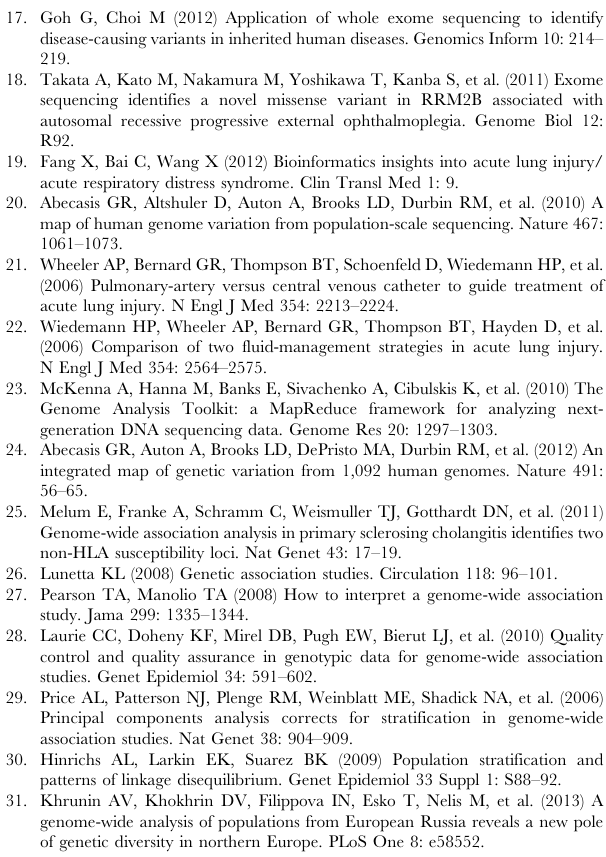
pants. *, Chi-square tests were run on SNPs that were in both the controls and the cases; A, alternate allele; r, reference allele. (DOCX) Table S8 A summary of the effect of the PCA adjust- ments on the genotypic trend test of the 3 SNPs. 2 of the 3 SNPs were present in the filtered Caucasian ARDS + EUR controls population. PCA, principal components analysis; PCs, principal components; AA, African American ARDS; ASW, African Americans in the southwest 1000 Genomes Project; EA, European Ancestry or Caucasian; corr/trend, trend association test. (DOCX) Supporting Information S1 The Supporting Information contains a detailed description of statistical methods used in this